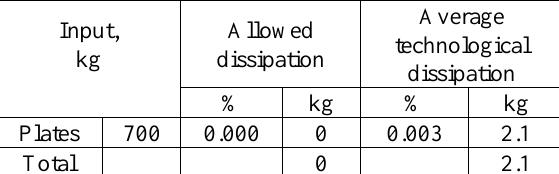
Allowed dissipation